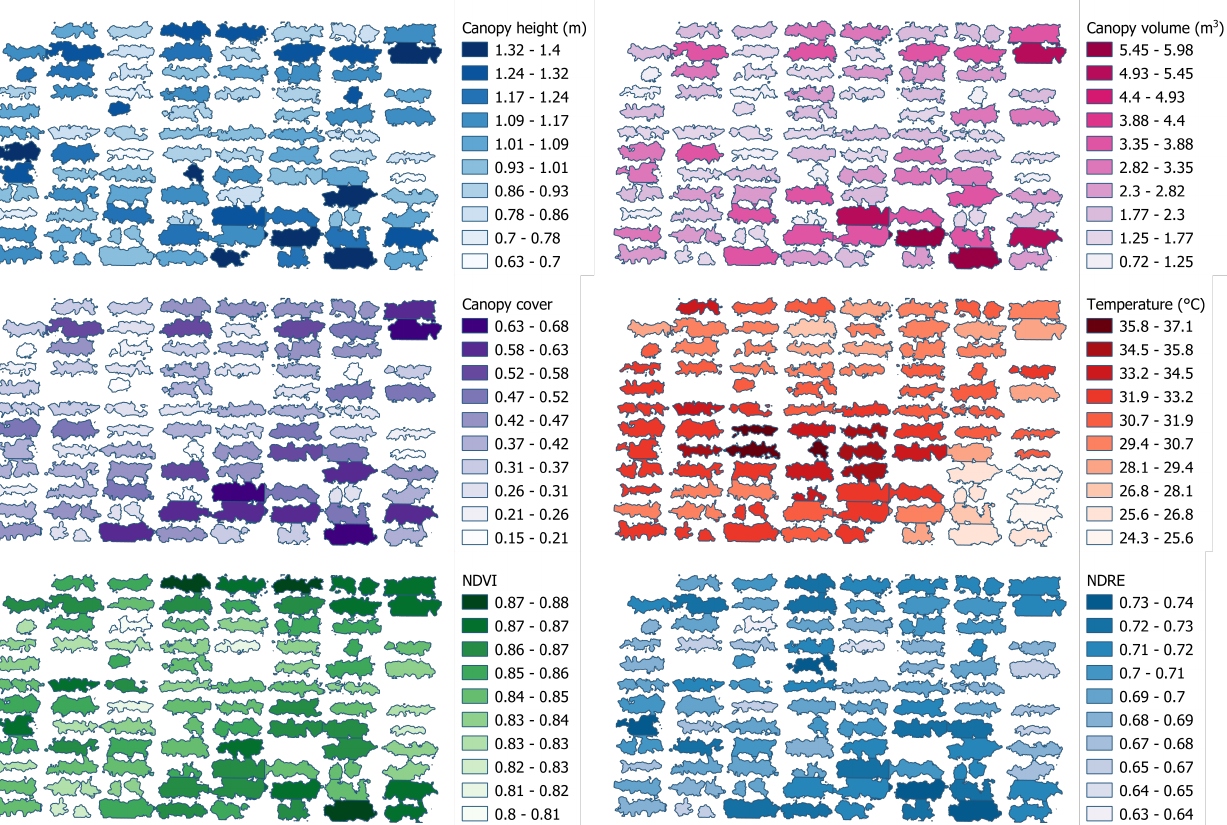
Figure 20. Visualization of the extracted phenotypical traits. The 99th percentile canopy height was used to represent the canopy